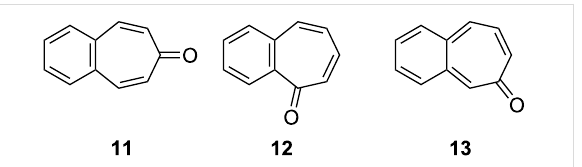
Figure 2: Possible isomers 11 – 13 of